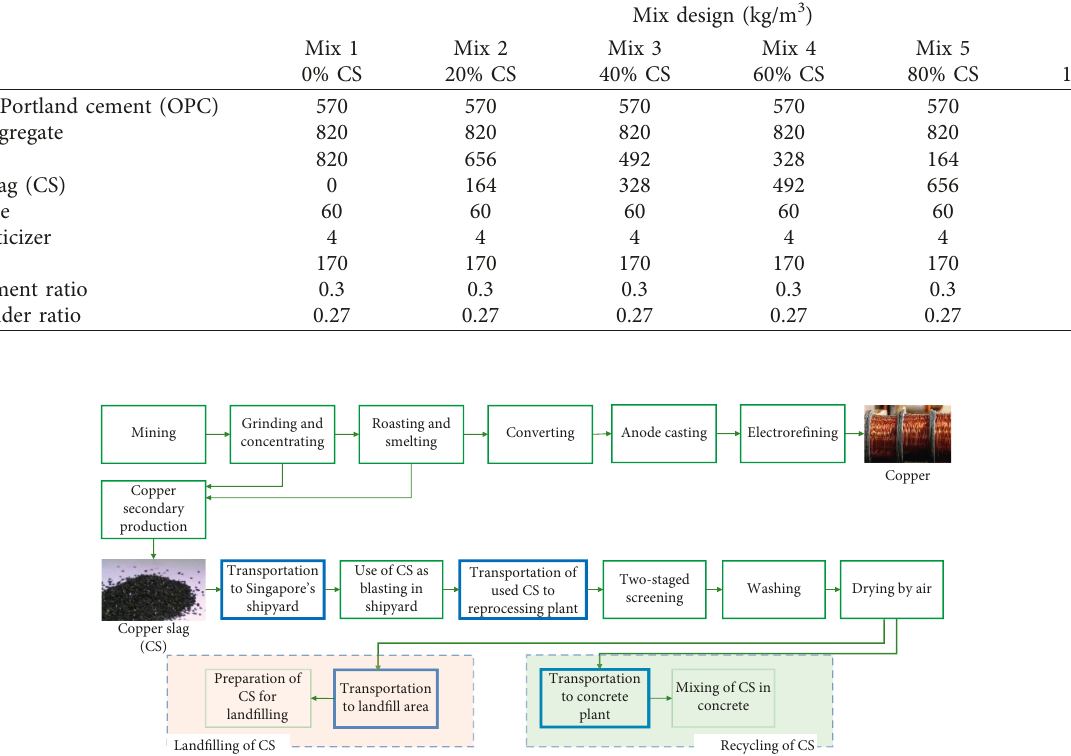
Figure 3: Process flow diagram for recycling versus landfilling of washed copper slag as sand replacement in concrete [35]. Table A.2 in the Appendix provides a snapshot of the